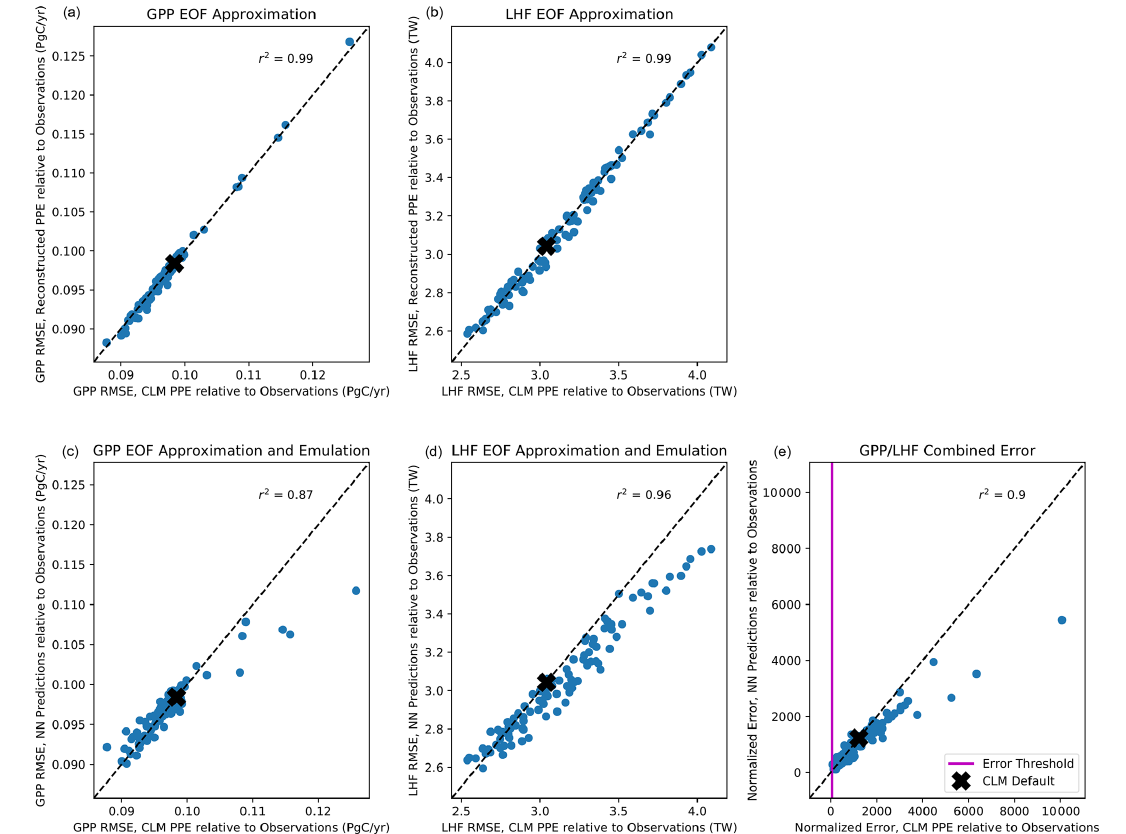
Figure 6. Scatterplot of root mean squared error (RMSE) across spatial grid points for GPP (a, c) and LHF (b, d) from the reconstructed EOF approximation relative to observations (a, b) and the reconstructed neural network (NN) predictions relative to observations (c, d) versus RMSE from CLM PPE relative to observations. Panel (e) shows the combined GPP/LHF normalized error relative to observations for the NN predictions versus the CLM PPE. The error threshold for the history matching experiment described in Sect. 4.2 is shown as a vertical magenta line. The errors resulting from the model with default parameters are shown as a black x in each panel. The one-to-one line is shown in each panel as a dashed black line, and r 2 values from a linear regression fit are included at the top of each panel.